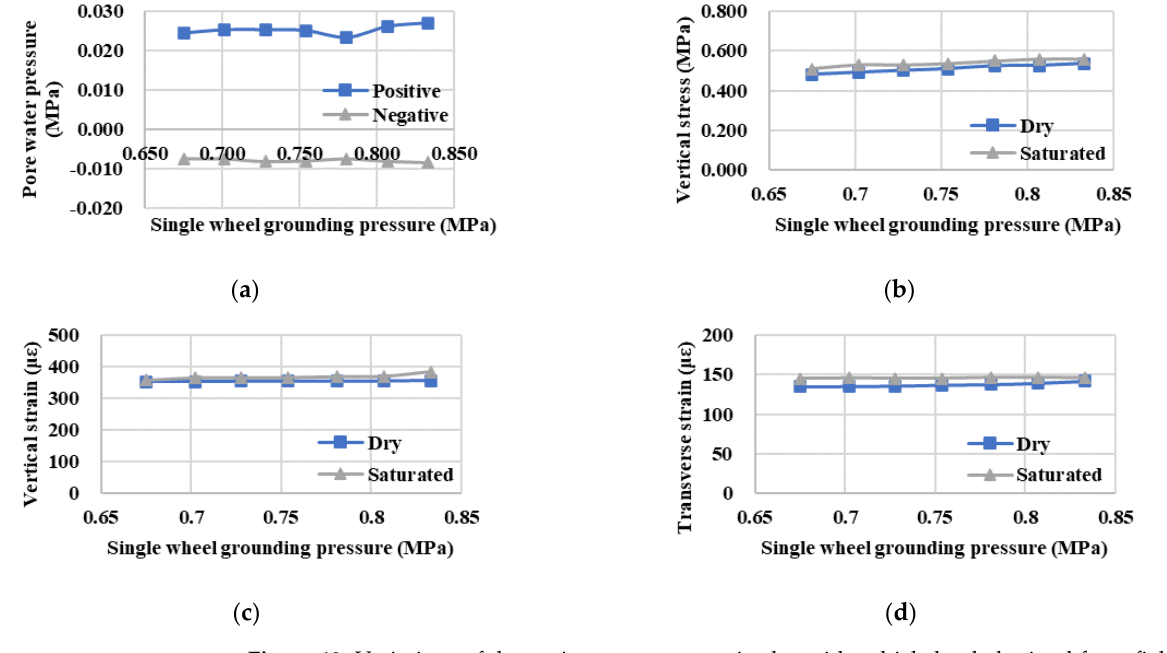
Figure 12. Variations of dynamic response magnitudes with vehicle load obtained from field tests (controlling vehicle speed at 20 km/h): ( a ) Pore water pressure; ( b ) Vertical stress; ( c ) Vertical strain; ( d ) Transverse strain.